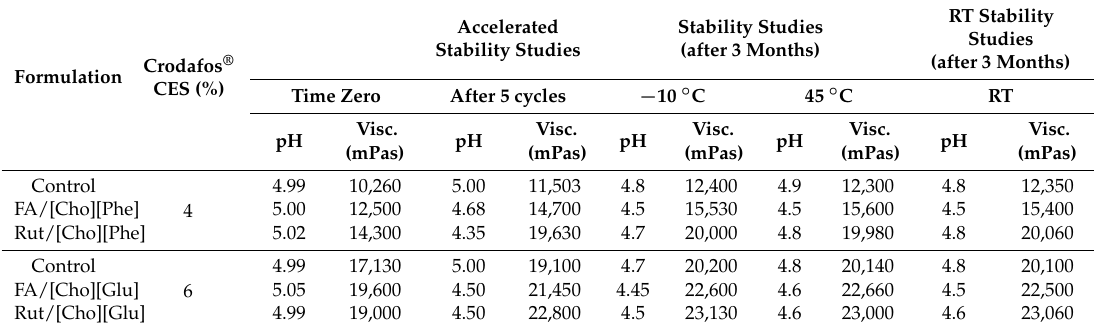
Accelerated Stability Studies Stability Studies (after 3 Months)